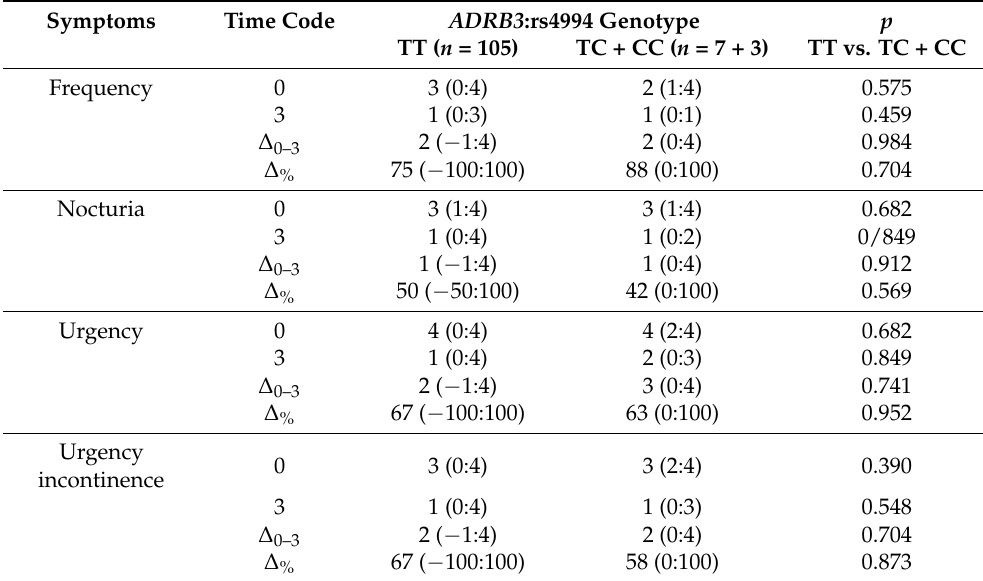
Table 2. OAB symptoms in women with overactive bladder, before and three months after intra- detrusor injection of botulinum toxin-A, in regard to ADRB3 :rs4994 genotype.